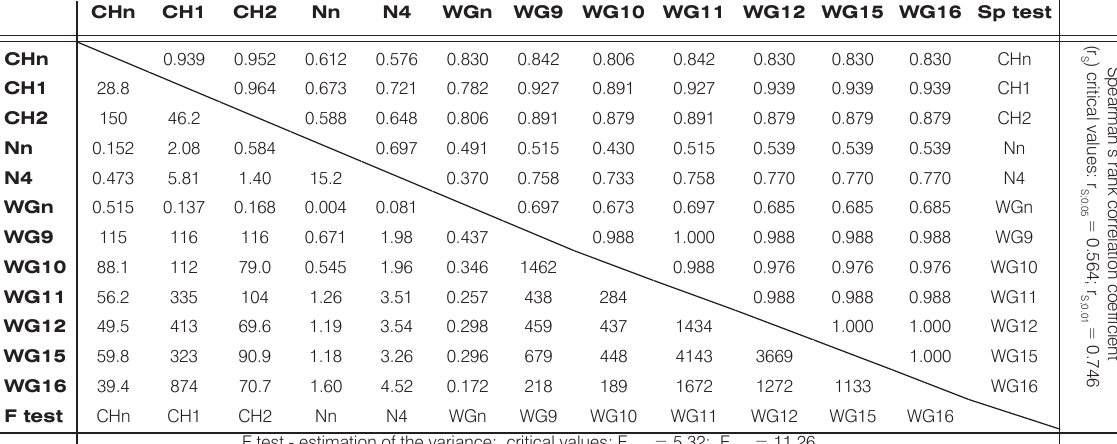
Table 5. Spearman’s rank correlation coefficient and variance correlation